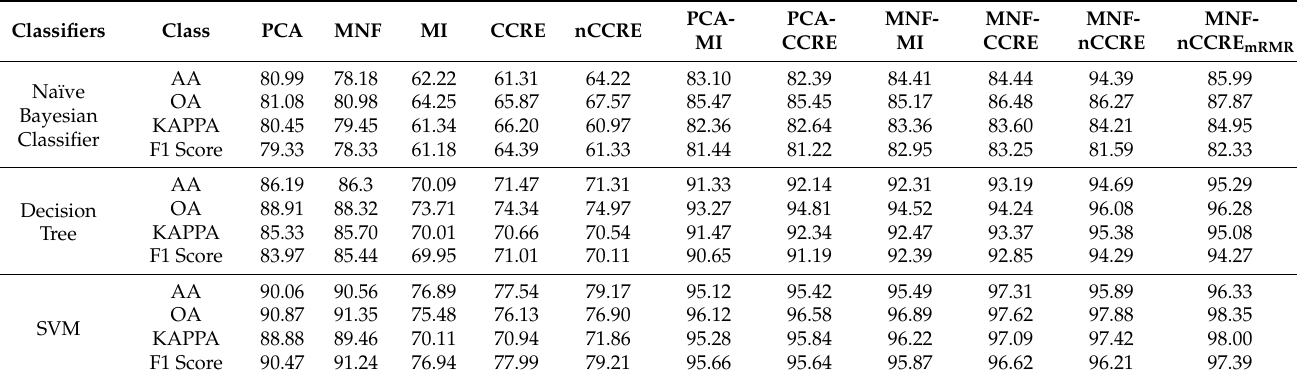
Table 15. Classification performance measure (%) on the ROSIS PU HSI for different dimension reduction methods and classification methods.